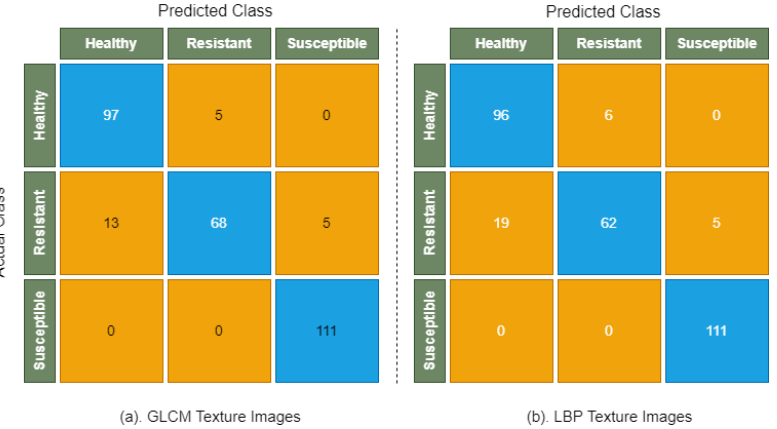
Figure 10. Confusion matrix of CatBoost on GLCM, LBP, and combined texture GLCM-LBP images.